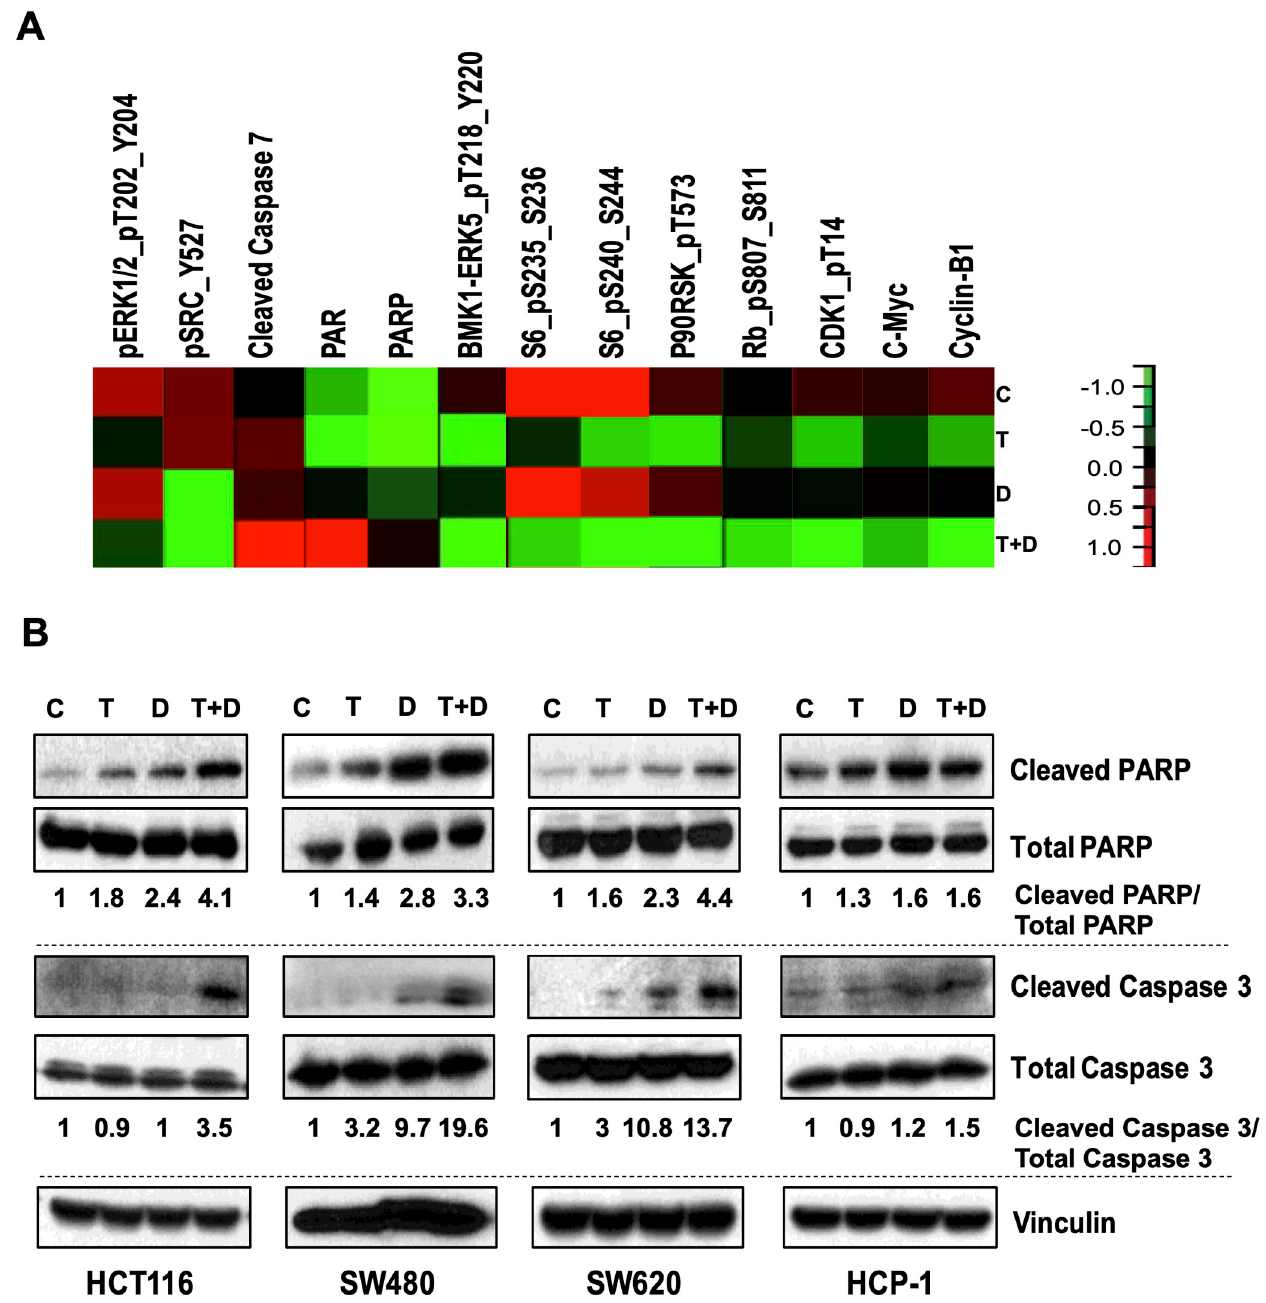
Fig 4. Combined SRC and MEK inhibition alters levels of multiple factors that regulate CRC cell proliferation and enhances apoptotic cell death in multiple KRAS-mutated CRC cell lines. A, heat map of results of RPPA analyses done to detect factors that regulate CRC cell proliferation and apoptosis in different KRAS-mutated CRC cell lines following treatment with trametinib (T), dasatinib (D), or both (T+D) for 48 hours. C, control. B , Western blots performed to detect the apoptosis markers cleaved PARP, total PARP, cleaved caspase 3, and total caspase 3 in multiple KRAS-mutated CRC cell lines. Vinculin was used as a loading control. The numbers below the blots denote the cleaved protein levels relative to total protein levels in each sample (Control cells standardized to 1).